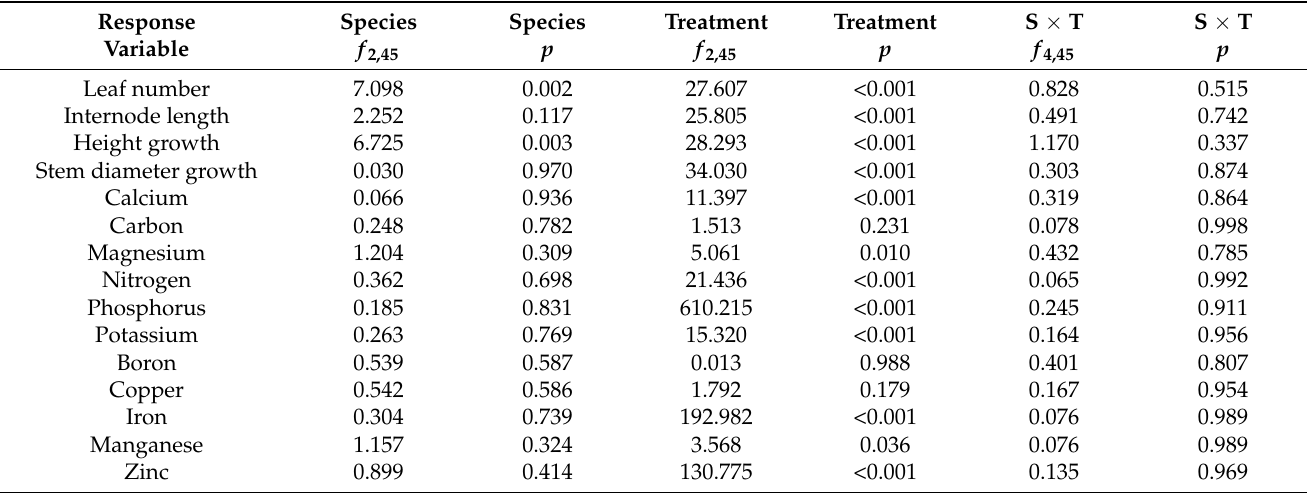
Table 5. Results from 3 species × 5 soil treatment factorial ANOVA. Four plant growth traits and leaf content of 11 elements.